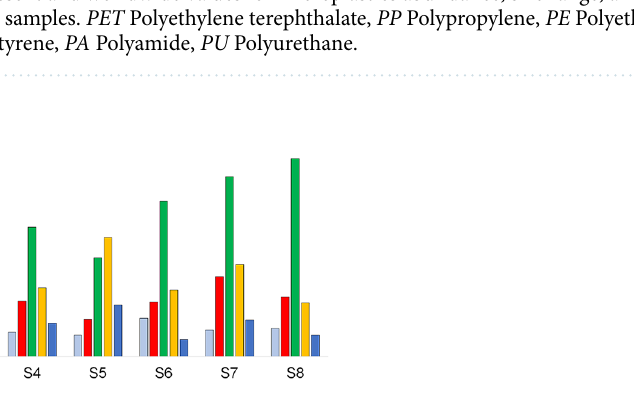
Figure 5. Microplastics abundance (particles kg −1 ) by shape category registered at the sampling sites S1 to